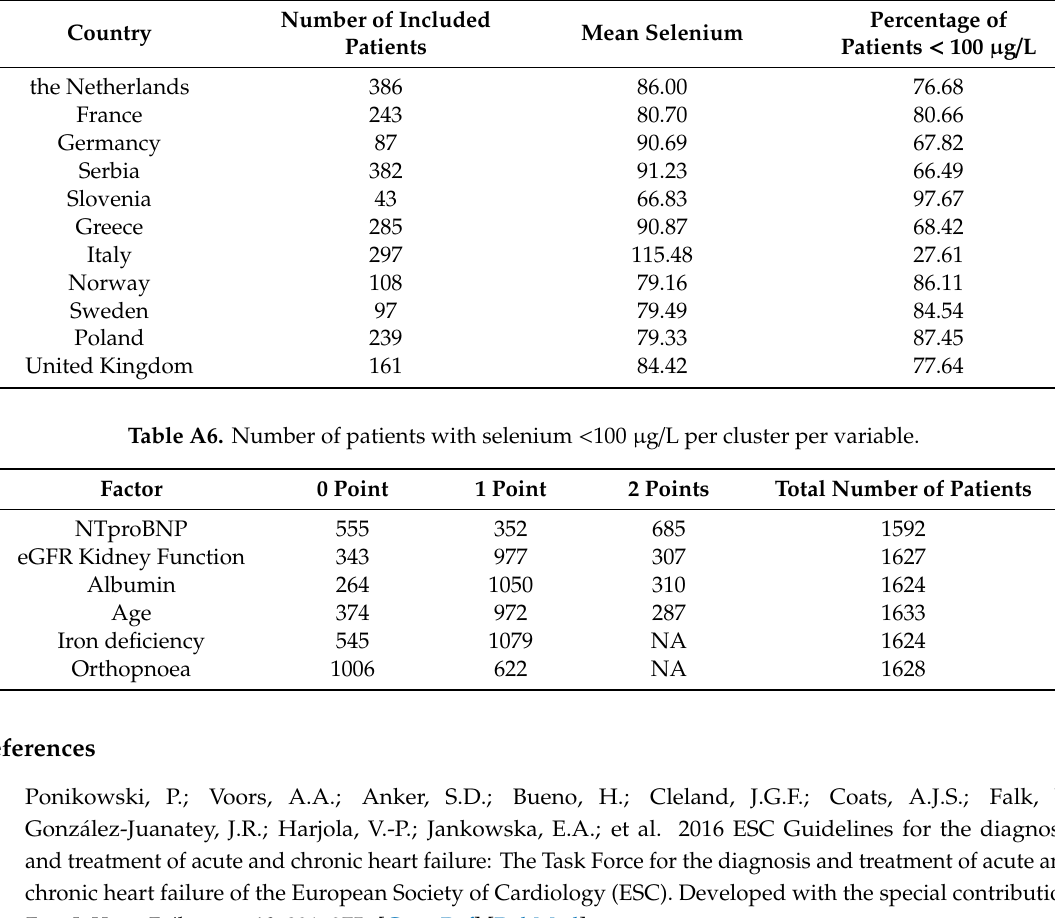
Table A5. Selenium values based on geographical location.